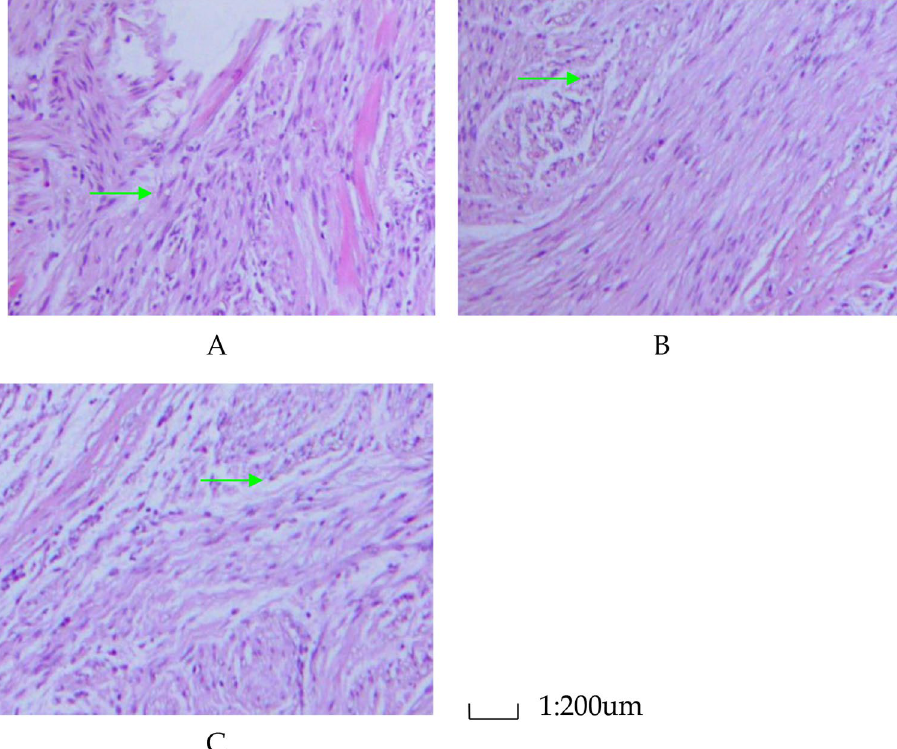
Figure 3. Analysis of Bsep expression by immunohistochemical assay. ( A ) Bsep expression in hilar cholangiocarcinoma of experimental group (magnification 200 ×). ( B ) Bsep expression in normal hilar bile duct from control group (magnification 200 ×). ( C ) Bsep expression in normal hilar bile duct from sham operation group (magnification 200 ×). The green arrows indicate Bsep . The Bsep protein expression which reacted with the anti- Bsep antibody were shown by immunohistochemistry. Each section included 4,800 cells. In the experimental group, 1,200 cells (25%) were positive, in the control group, 3,648 cells (76%) were positive and in the sham operation group 3,598 cells (75%) were positive, and this difference was statistically significant. ( χ 2 = 10.28, P < 0.05, between experimental group and control group. χ 2 = 10.26, P < 0.05 between experimental group and sham operation group). (SPSS22.0 http://www.downx ia.com/downi nfo/16552